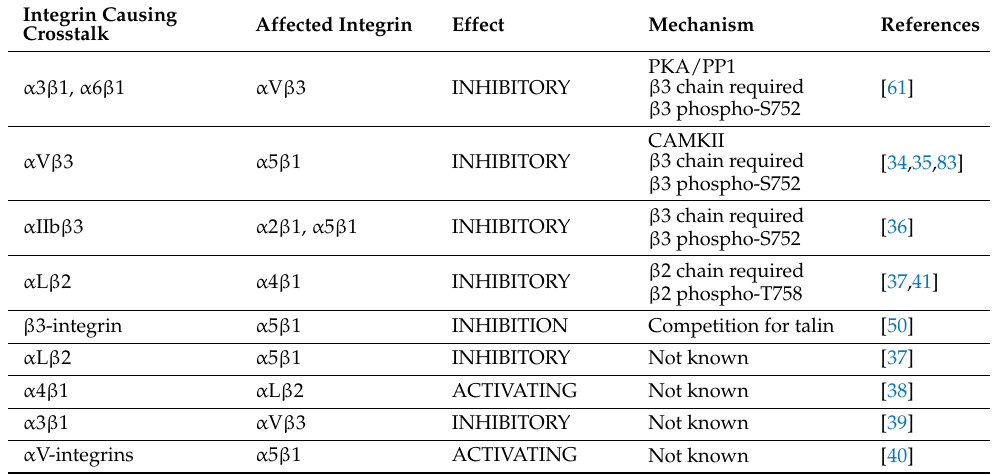
Table 1. Examples of integrin